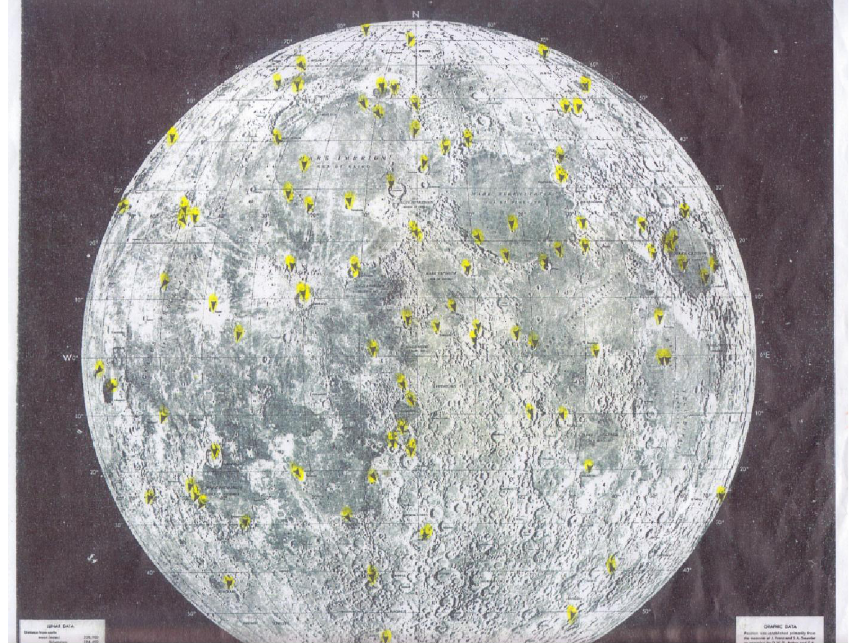
Figure 2. Lunar Transient Sites. Some 2254 changes on the surface of the moon have been reported over the last 500 years. The figure shows the location of some of the transients. Many appear to cluster at the margins of maria. The author believes transients may represent defluidization sites along fractures possibly intensified by tidal flexing. Most reports of transients are in Aristarchus 23.7N, 47.4W. Radon and argon have been reported in fractures associated with Aristarchus which has been interpreted as a “dawn” effect. Cyanogen has been spectroscopically verified at Aristarchus as a transient phenomenon.